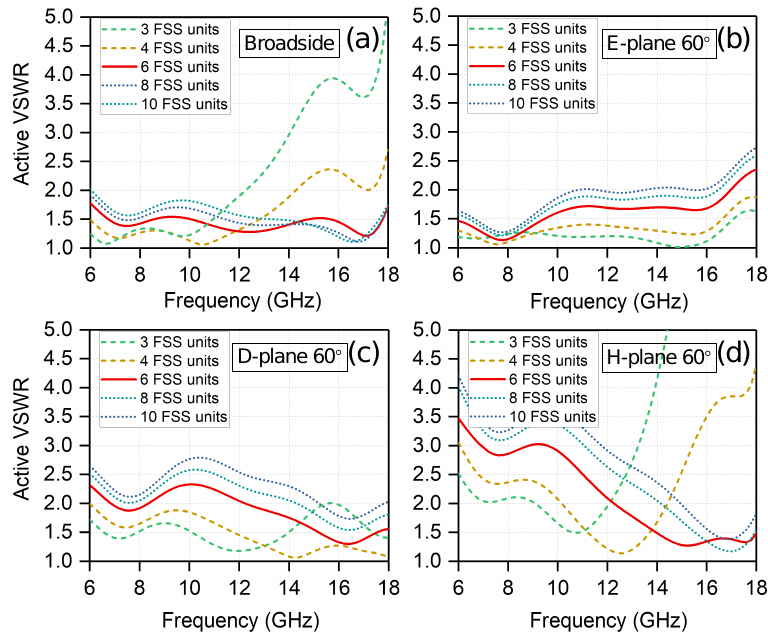
Figure 8. The impacts of the number of FSS units within an antenna unit cell on the active VSWR when scanning to ( a ) broadside; ( b ) 60 ◦ in the E-plane; ( c ) 60 ◦ in the D-plane; and ( d ) 60 ◦ in the